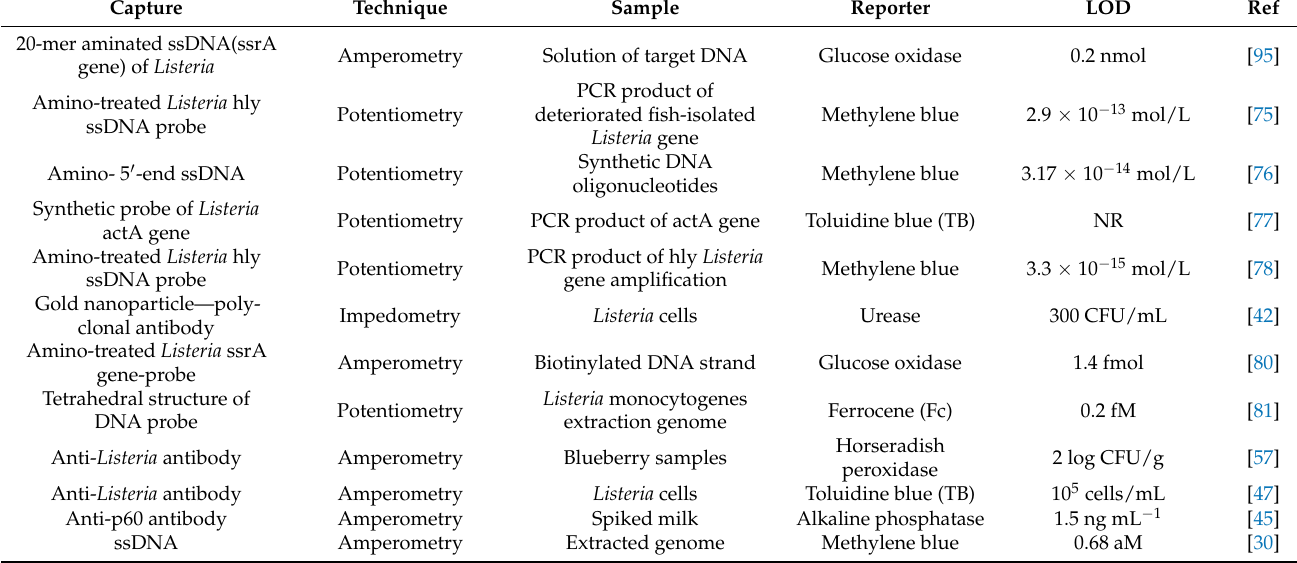
Table 4. Various labels have been utilized in sensors for the detection of